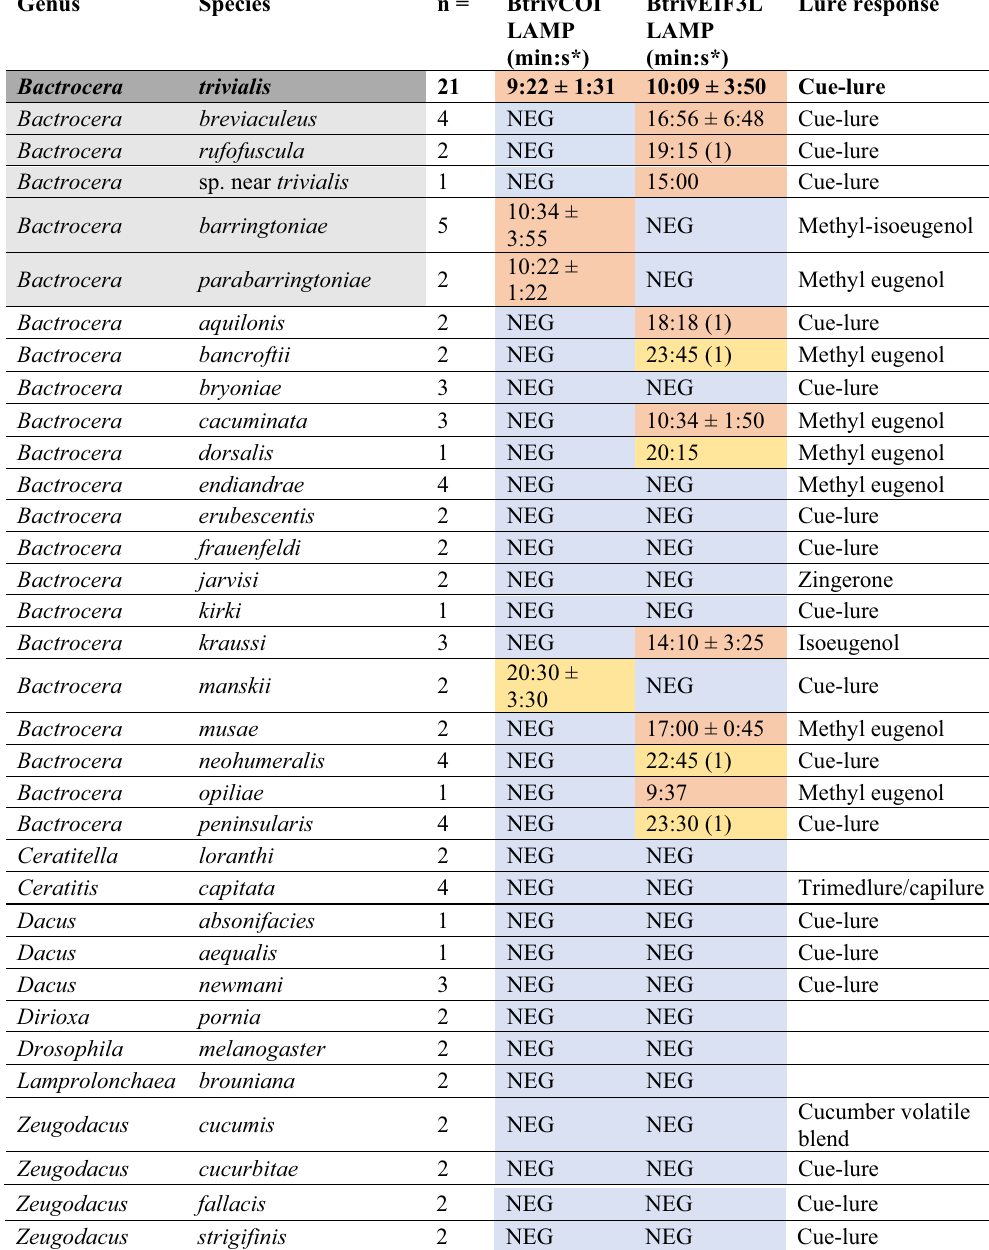
Table 2. Results from the panel testing for both BtrivCOI and BtrivEIF3L LAMP assays. Blue = no observed amplification, orange = amplification < 20 min (early), and yellow > 20 min (late); brackets indicate number of samples used to calculate average amplification time, where positive amplification of a species was variable. The target species, and samples morphologically or genetically similar are highlighted in grey; all other species are listed alphabetically. Lure response of each panel species (if any) is also presented 4,15,32 . NB: see supplementary table for individual specimen results. *Average +/− standard